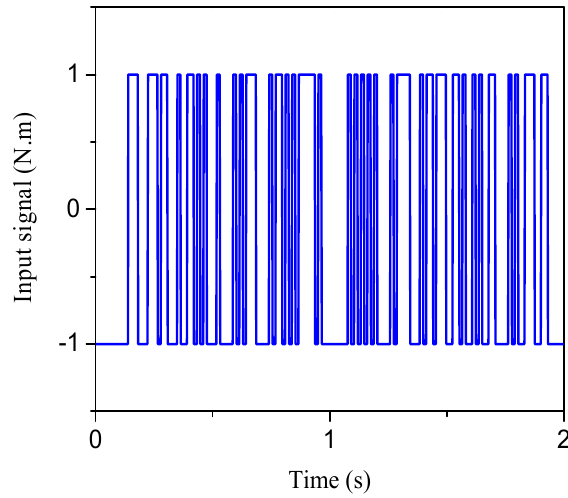
Algorithms 2019 , 12 , x FOR PEER REVIEW Figure 15. Bode plot of the EPS using different identification algorithms. Figure 15. Bode plot of the EPS using different identification algorithms.